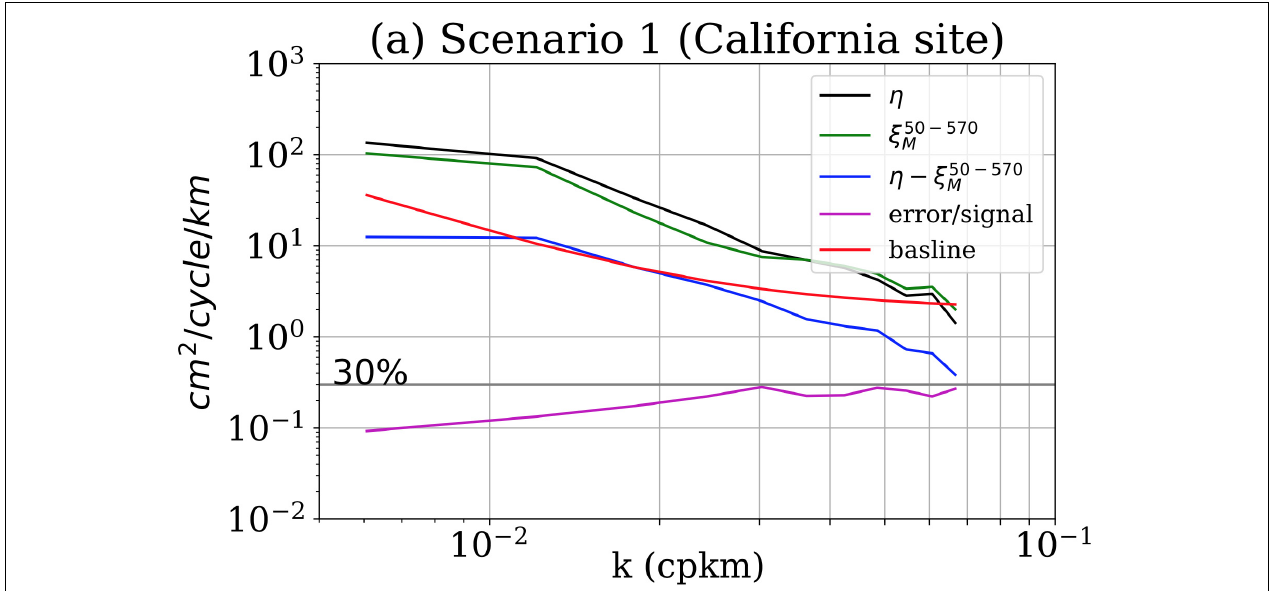
FIGURE 6 | The wavenumber power spectrum density of the true SSH anomaly η (black), the mooring reconstruction ξ M (green), the residual η – ξ M (blue), the error-to-signal ratio (purple), and the baseline (red). Visual guide of the 30% (0.3) level (horizontal line) (Wang et al., 2018; copyright 2018, American Meteorological Society